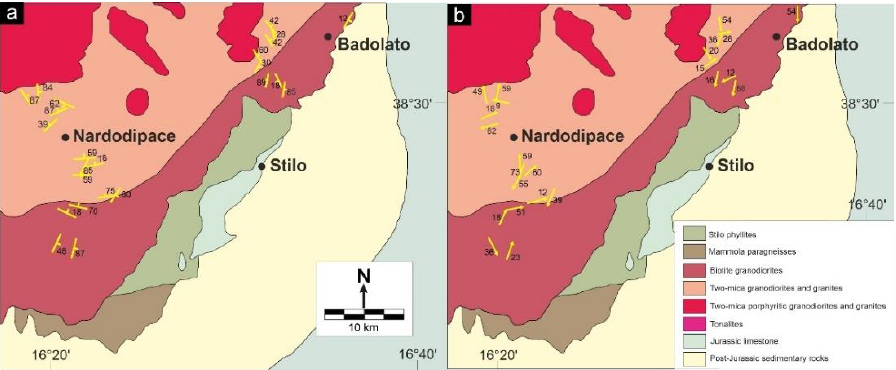
Figure 8. Maps of the magnetic foliations ( a ) and lineations ( b ) in the upper crustal levels of the Serre Batholith.